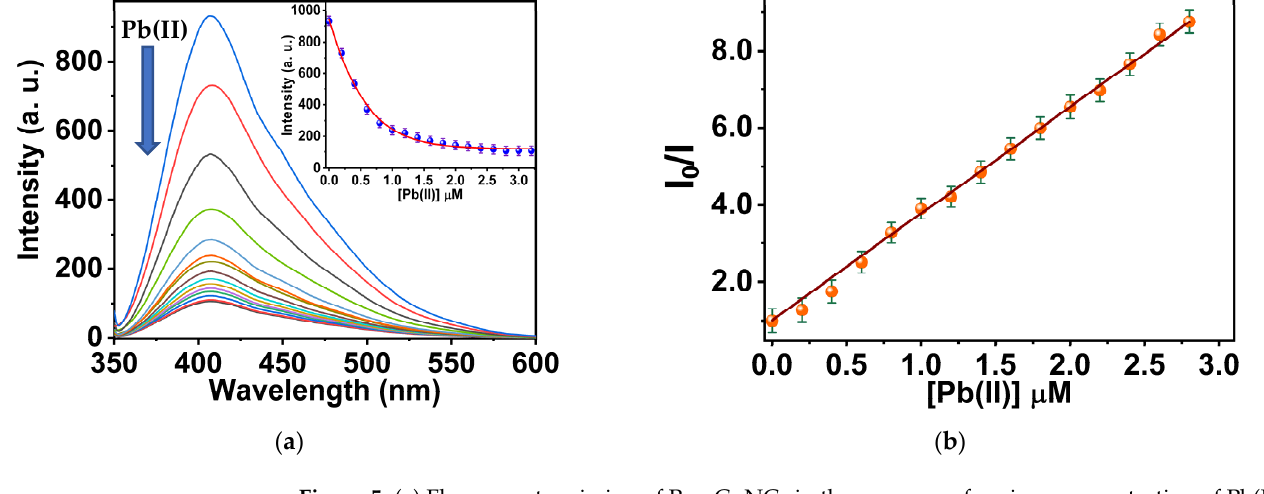
Figure 5. ( a ) Fluorescent emission of Pep-CuNCs in the presence of various concentration of Pb(II) ions from 0.1 to 6 mM; ( b ) Classical Stern-Volmer plot of fluorescence intensities ratio to the Pb(II).